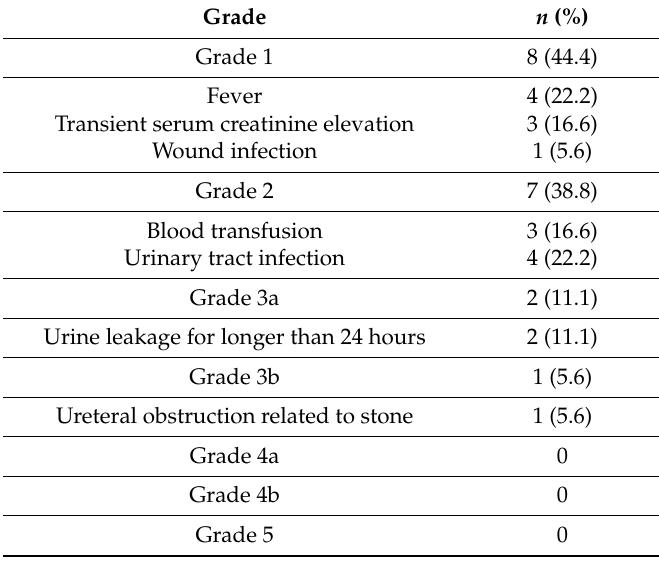
Table 5. Complications according to modified Clavien